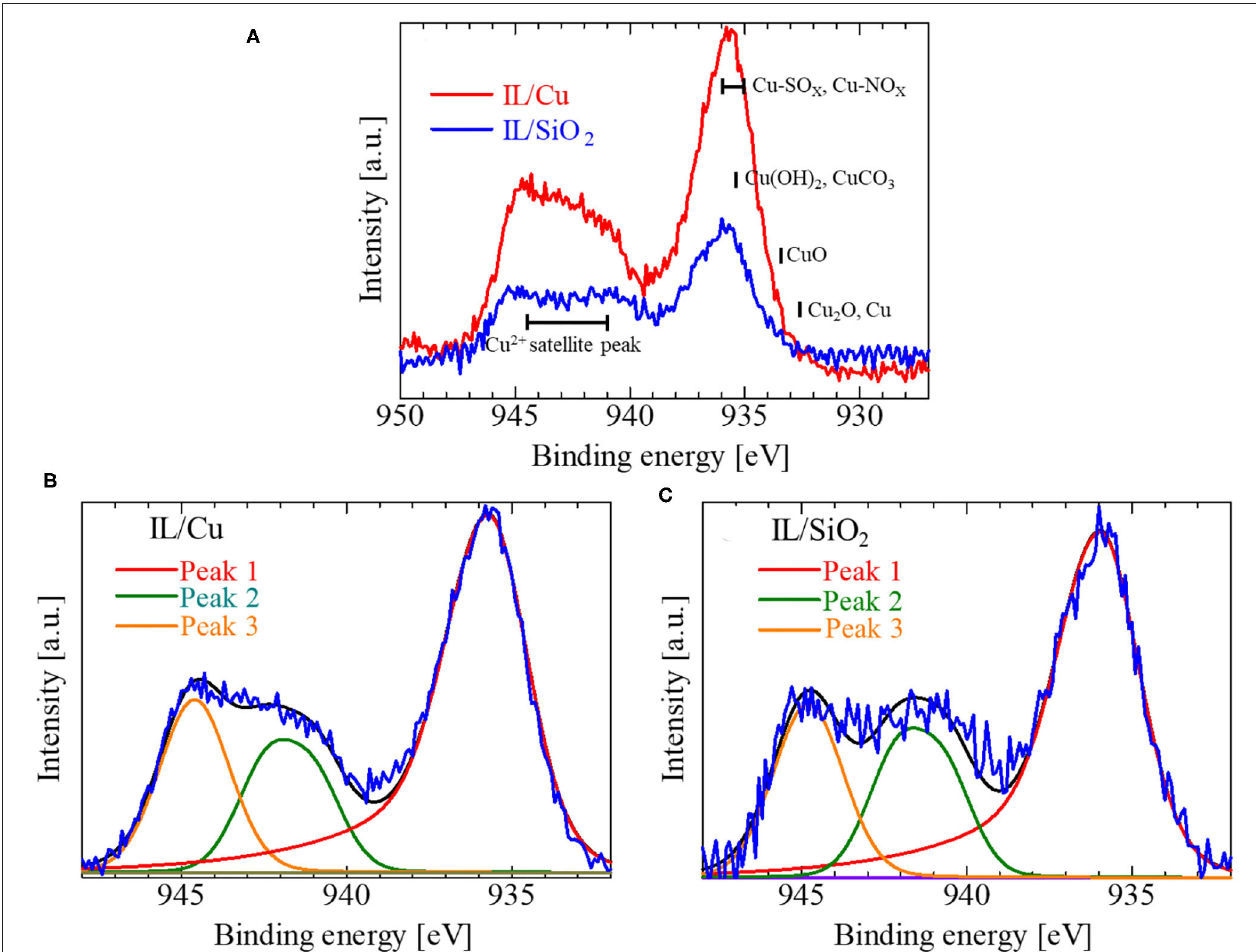
FIGURE 5 | (A) Cu 2p 3 / 2 spectra for IL/Cu and IL/SiO 2 and the waveform analysis results for the Cu 2p 3 / 2 spectrum in (B) IL/Cu and (C) IL/SiO 2 . In (A) , the peak positions for some typical Cu compounds as well as Cu(II) satellite peaks are represented by the solid black bars. In (B,C) , red, green, and orange curves are the fitting results for the peak separation. Black curves are the summation of those